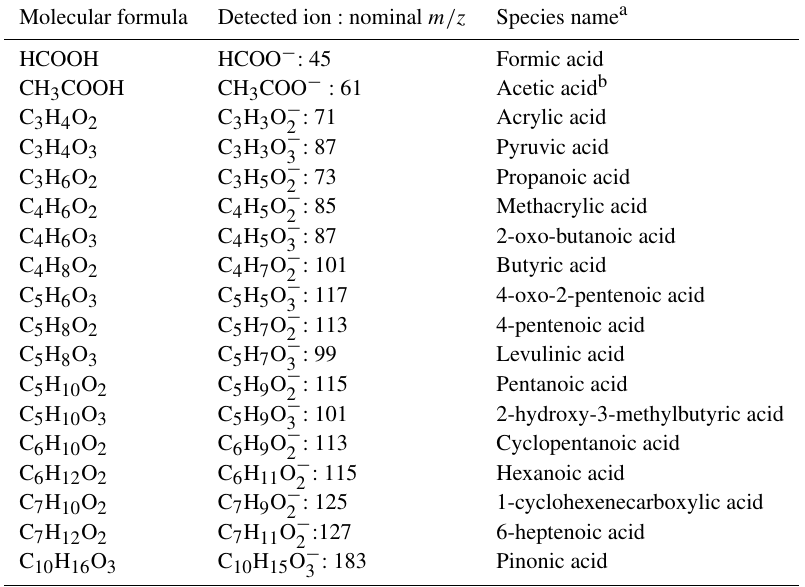
Table 1. Molecular formulas and associated species names for organic acids detected during aircraft measurements. Molecular